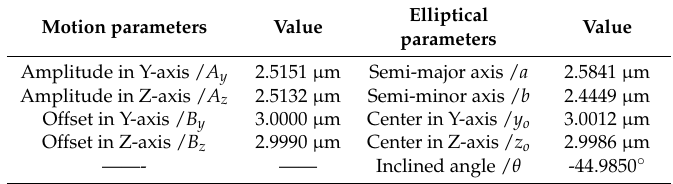
Table 2. The experimental results and fitting elliptical parameters of the